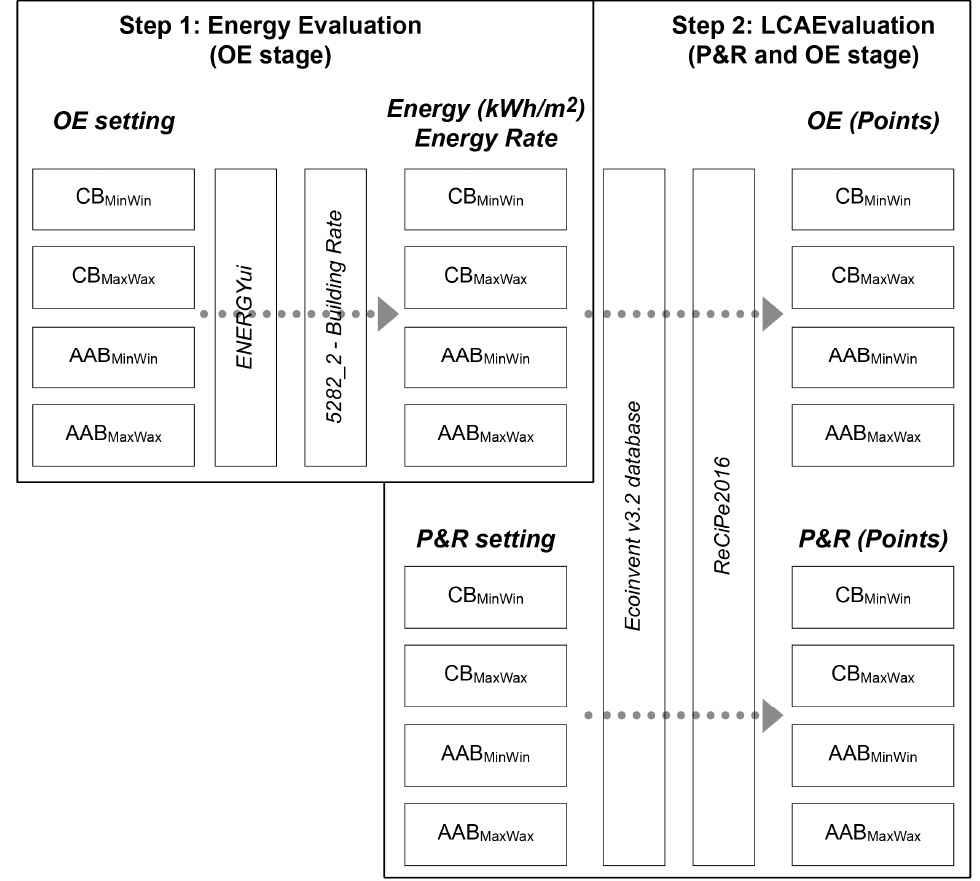
Figure 2. A flow chart diagram of the methodology for two-step evaluation procedure of CB MinWin , CB MaxWin , AAB MinWin , and AAB MaxWin .